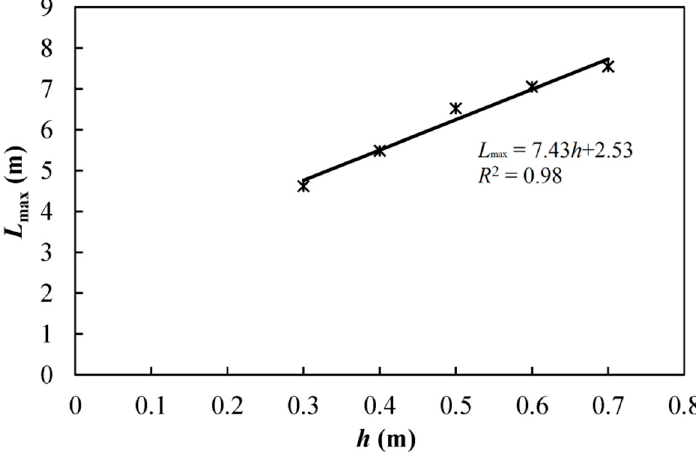
Figure 2. Relationship between the maximum upstream distance in the subsurface flow influenced by the weir ( L max ) and the height of the weir ( h ).